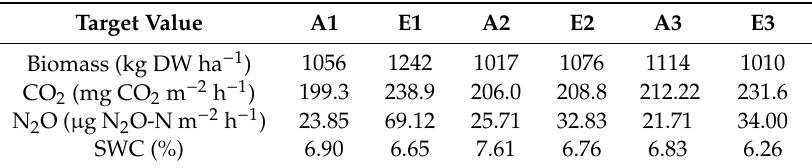
Table A3. Average RMSE of the behavioral simulation